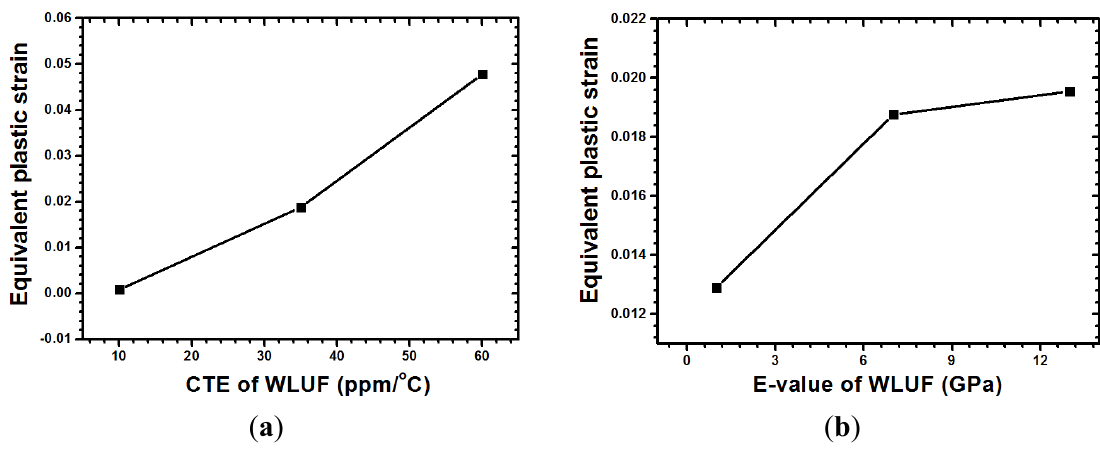
Figure 18. Response of equivalent plastic strain for the main designed factor: